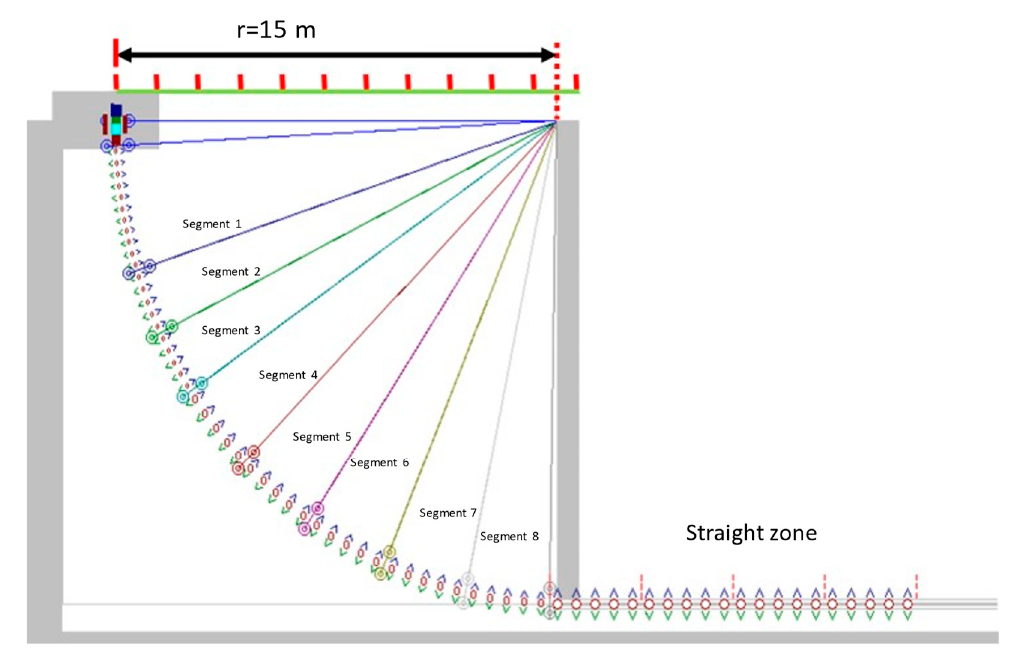
Figure 15. Layout of the slab caster. Table 6. General configuration of the CCM for casting slabs. Table 7. Dimensions of the SCS in the curve zone (for slabs).